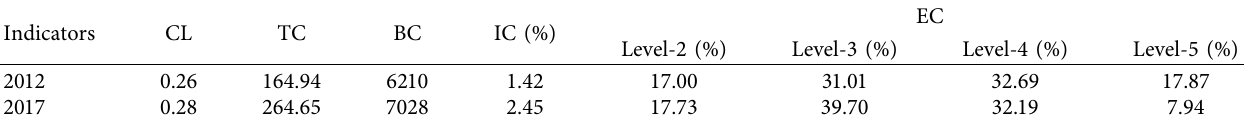
Figure 2: Te ICNs of the MLYR in 2012 and 2017. (a) 2012. (b) 2017. Table 3: Te network circulation efect of the ICN in the